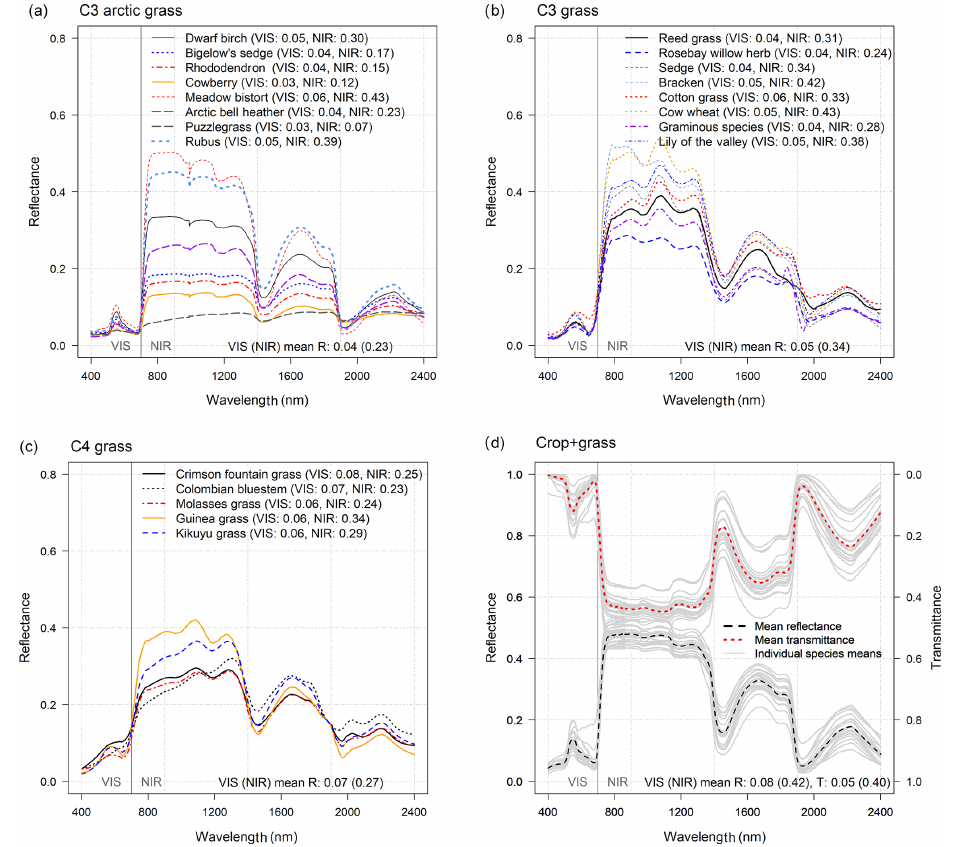
Figure 5. Optical properties of grasses and crops. Reflectance ( R (λ) ) of (a) C3 arctic grasses, (b) C3 grass canopies, (c) C4 grass canopies, and (d) and transmittance ( T (λ) ) of leaves of different crops ( n = 21, contains also some grass species): individual-species-mean R (λ) and T (λ) are shown using light gray lines and are used to represent within-PFT deviation in mean spectra (see individual species values in S2). The mean R and T for VIS (400–700nm) and NIR (701–2400nm) wavelengths are provided at the bottom of the images and are calculated as an average across-species means. Note that all VIS and NIR averages of R (λ) and T (λ) were weighted with solar irradiance spectra (SI (λ) ) . Table 4. Mean leaf inclination angles (LIAs) of different flat-leaved plant functional types (PFTs). The angles are provided both in degrees ( ◦ ) and as departures from a spherical distribution ( χ L ) . Number of observations is shown in column “ n ”. Individual species estimates are presented in Table